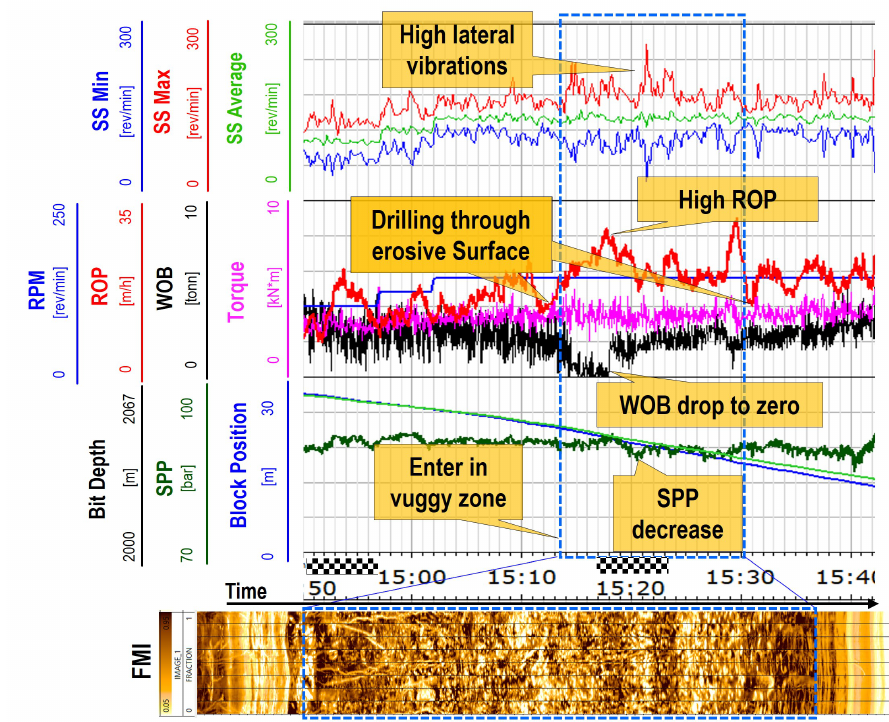
Figure 5. Drilling mechanics data in the interval of vugs based on the field data from the Loppa High region—courtesy of Lundin Energy. See Table 1 for the description of the logged